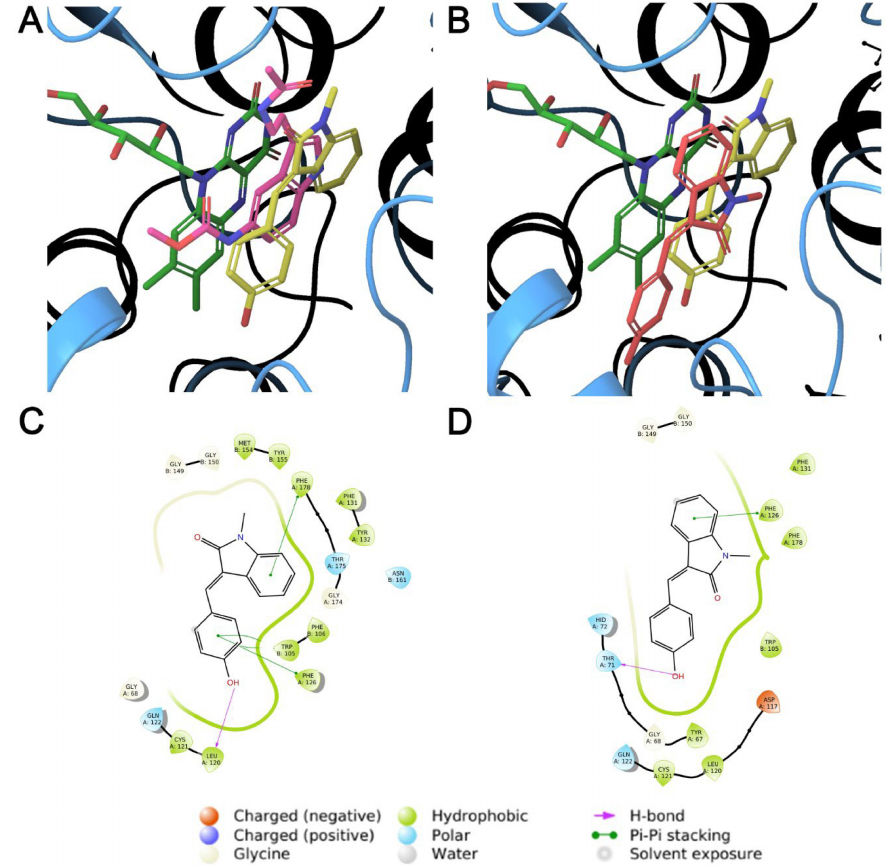
Figure 5. Proposed binding models of MCA-NAT and 15 to active site of NQO2 (blue) with FAD (green). ( A ): binding pose of MCA-NAT (purple) and E -isomer (yellow) of 15 . ( B ): E - (yellow) and Z - (red) isomers of 15 . ( C ): interaction map for the E -isomer of 15 . ( D ): interaction map for the Z -isomer of 15